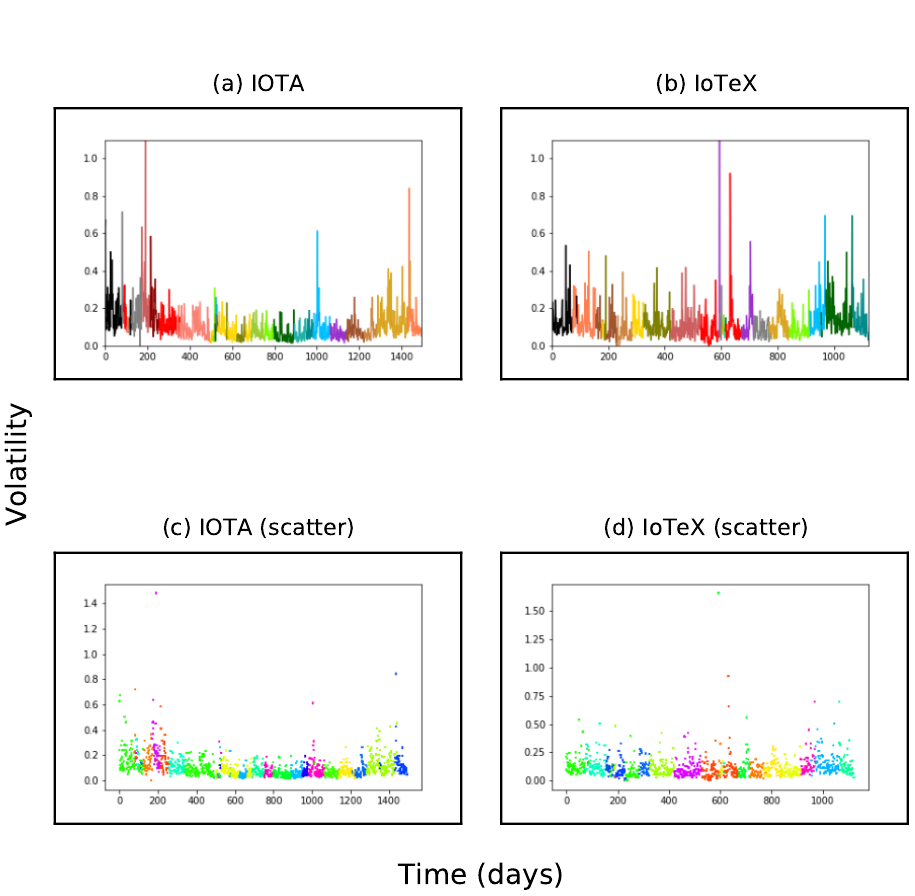
Figure 7. Communities identified by the networkx module community API in IOTA, ( a , c ), and Io- TeX, ( b , d ). Graphs ( a , b ) use a coloured-coded continuous line and graphs ( c , d ) a coloured-coded scattered